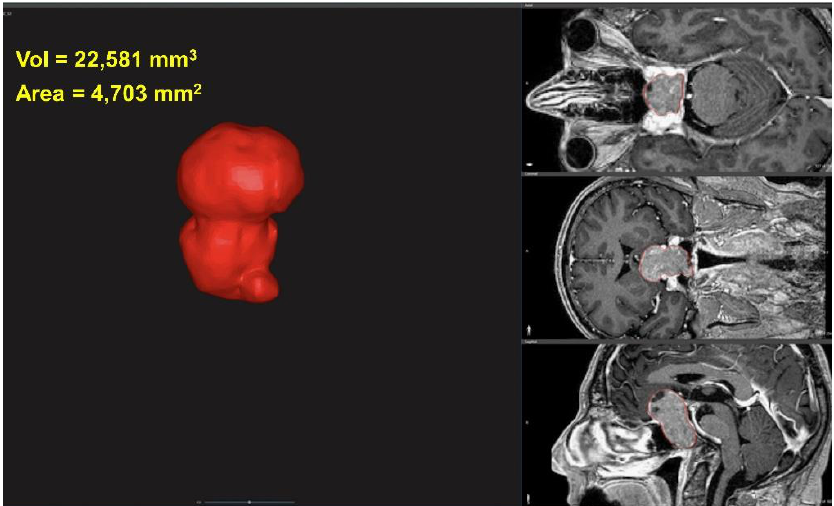
Figure 1. Example of segmented pituitary gland tumor obtained using D2P™ software, from MR scan. Vol = tumor volume; Area = tumor area.